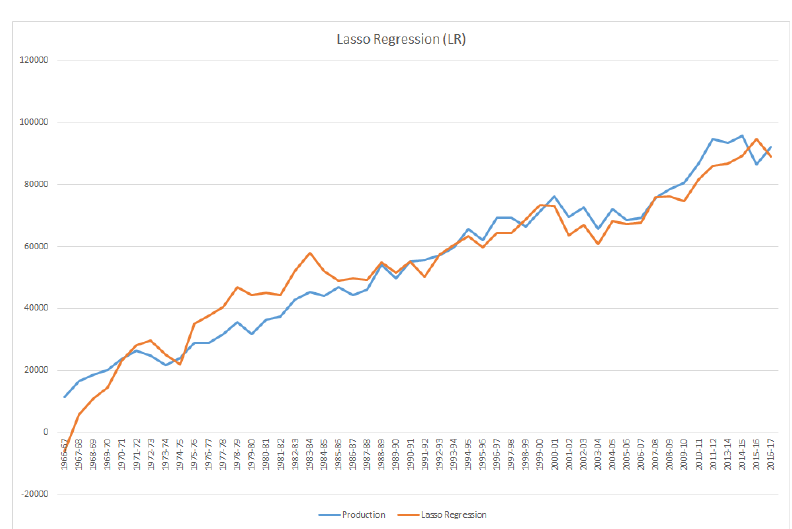
Figure 4: Forecasting using Lasso